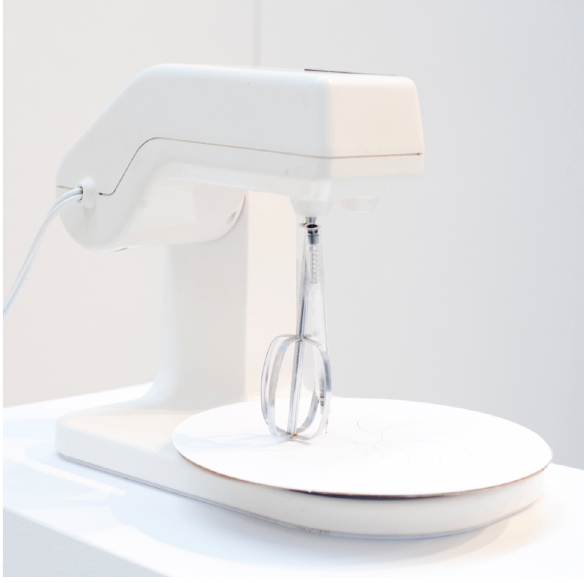
Figure 7 | Mixer Drawing Nr. 9. Messiness of the analog medium.